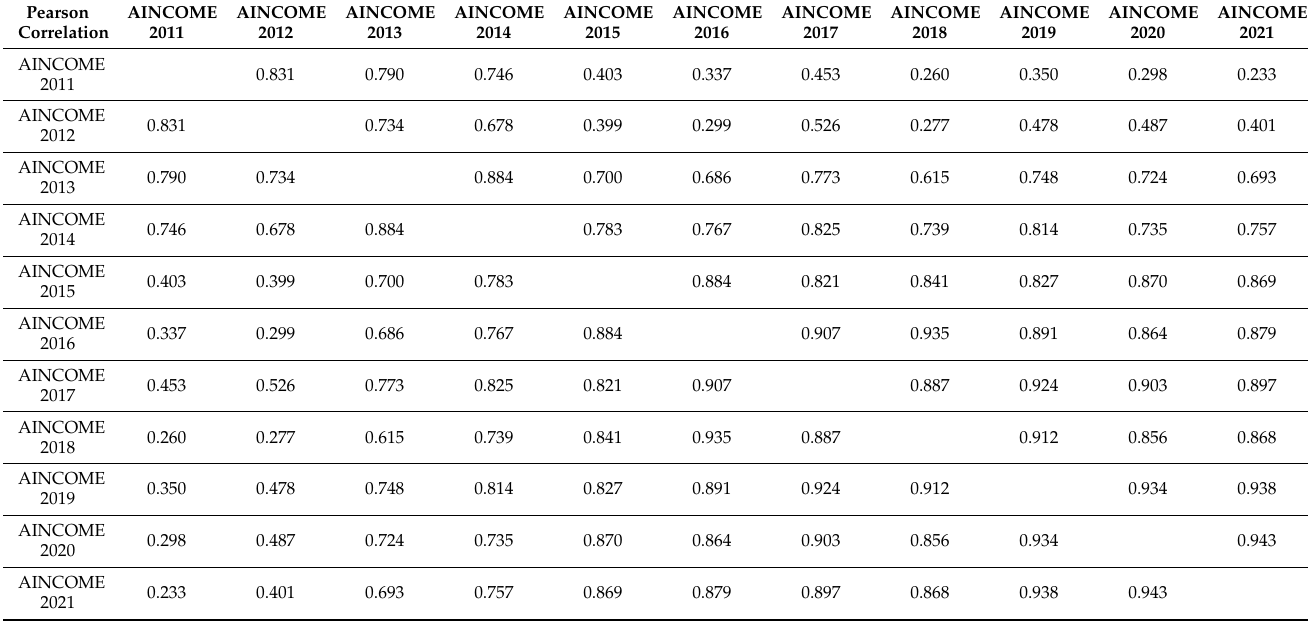
Table A1. Pearson correlation rates in dynamics for the agricultural income indicator.